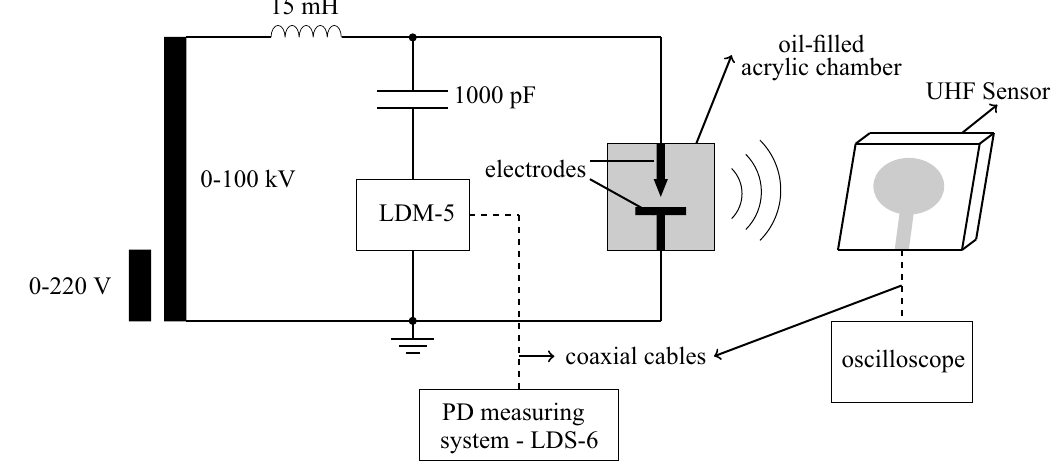
Figure 14. Measurement setup used for PD detection.